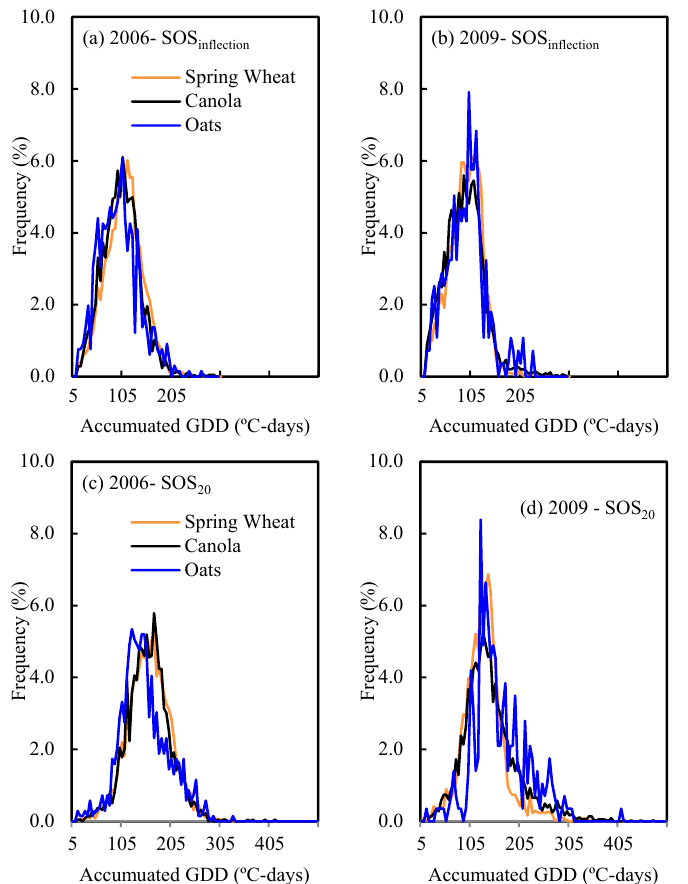
Figure 6. Histogram of AGDD from seeding date to the remotely sensed SOS using the inflection-based (SOS inflection ) and that using the threshold-based method (SOS 20 ) for 2006 ( a , c ) and 2009 ( b , d ), respectively. Table 3. Summary of the distribution of accumulative growing degree days (AGDD) from observed seeding date to remotely sensed SOS (AGDD SOS ) for different crops and years; µ and σ are the average value and the standard deviation value of AGDD SOS , respectively.